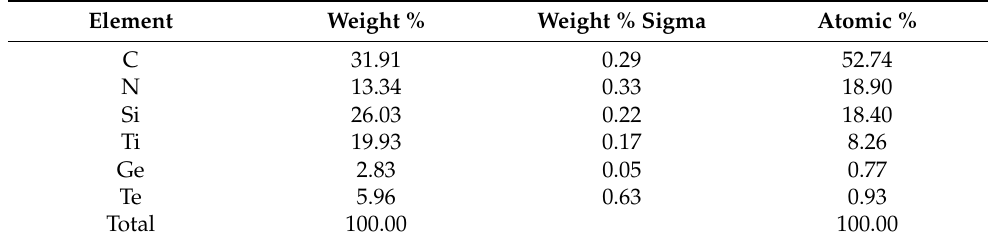
Figure 6. ( a ) Cross-sectional view of the Si/SiO2/TiN/GT/TiN device. The top of the sample carbon layer was deposited for analysis. ( b ) Map of the sample with every element of the sample. ( c ) Map sum spectrum of the device. Table 1. Map sum spectrum of the TiN/GT/TiN